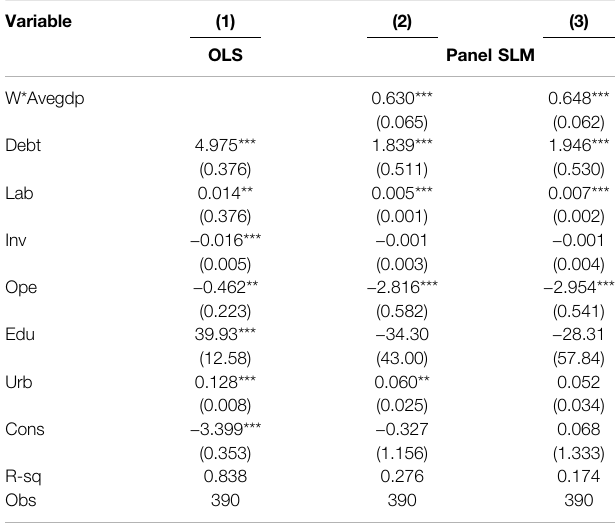
TABLE 4 | OLS and SLM test results of the impact of the local government debt level on regional economic growth in 2006 – 2018.